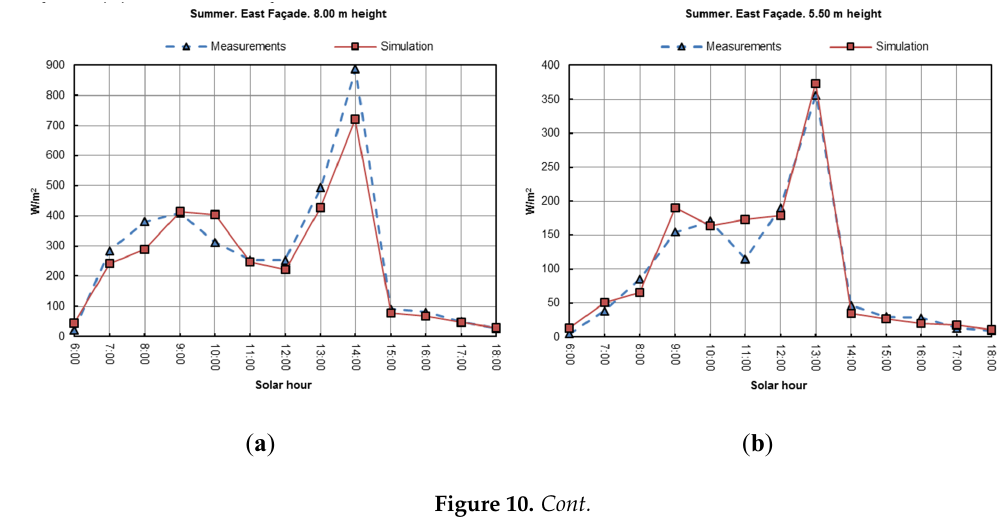
Figure 9. R 2 , RMSE and NRMSD between cell measurements and simulations in Cadiz. ( a ) N-E 28º Façade. ( b ) S-W 208º Façade.